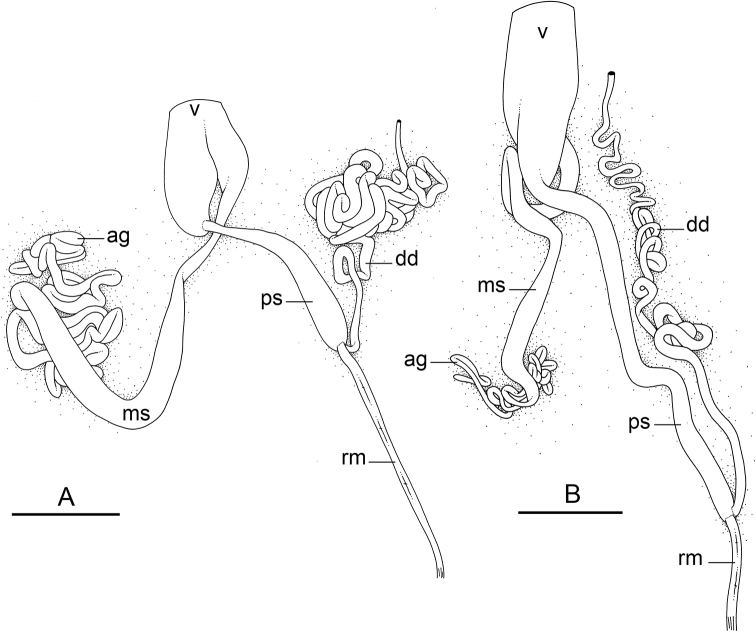
Anterior, male, copulatory apparatus, Peronia
madagascariensisA Madagascar, [5501] (MNHN-IM-2009-16392) B South Africa, [5841] (NMSA W7547). Scale bars: 5 mm (A), 2 mm (B). Abbreviations: ag accessory penial gland, dd deferent duct, ms muscular sac, ps penial sheath, rm retractor muscle, v vestibule.